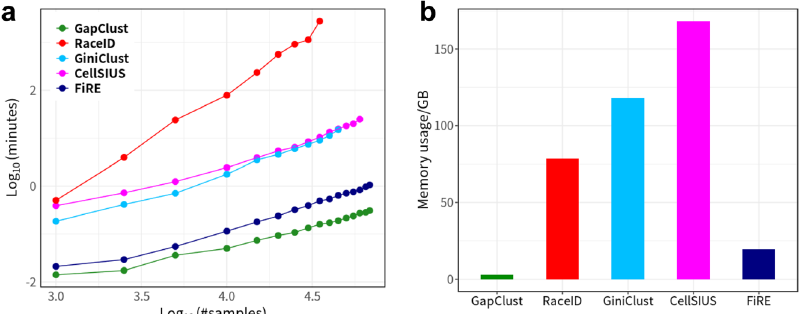
Fig. 4 GapClust is fast and memory ef fi cient. a Execution time recorded for the fi ve methods (GapClust, RaceID, GiniClust, CellSIUS and FiRE) while varying the number of cells from 1 k to ~68 k. b Maximum memory usage for the fi ve methods in processing cells with number varying from 1 k to ~68 k.